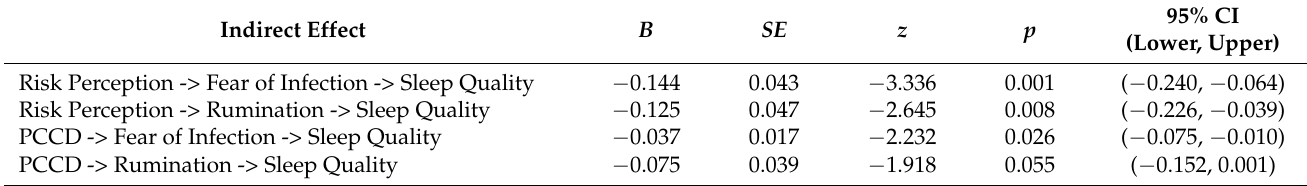
Table 5. Indirect effects.